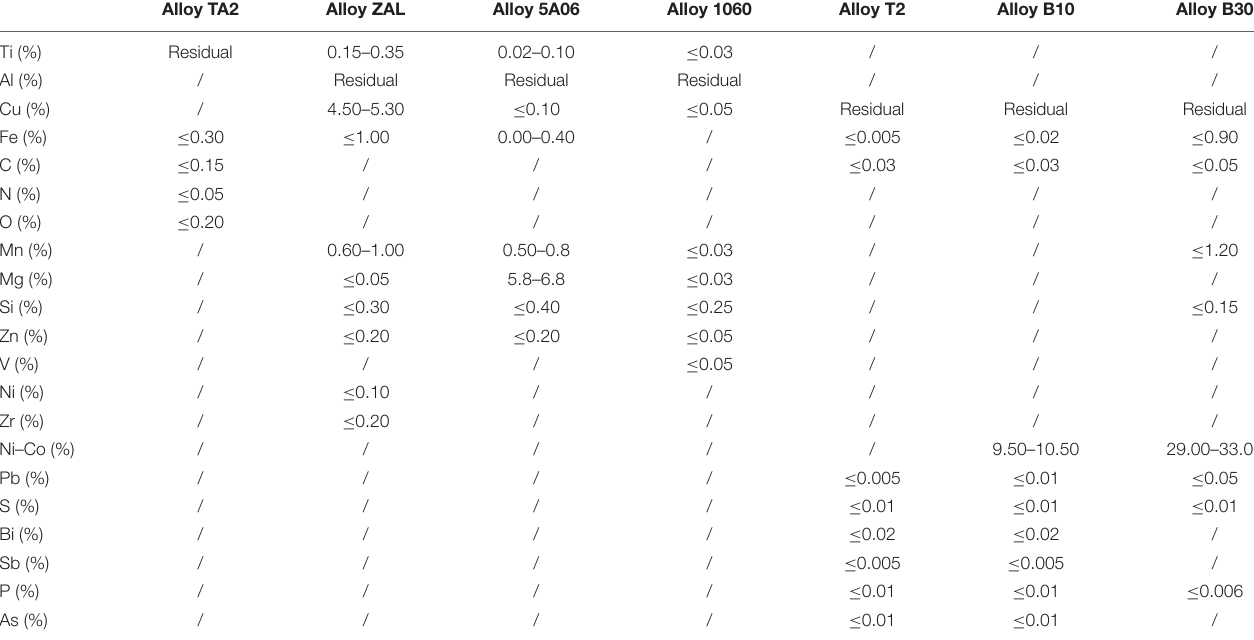
TABLE 1 | Chemical composition of the alloys.